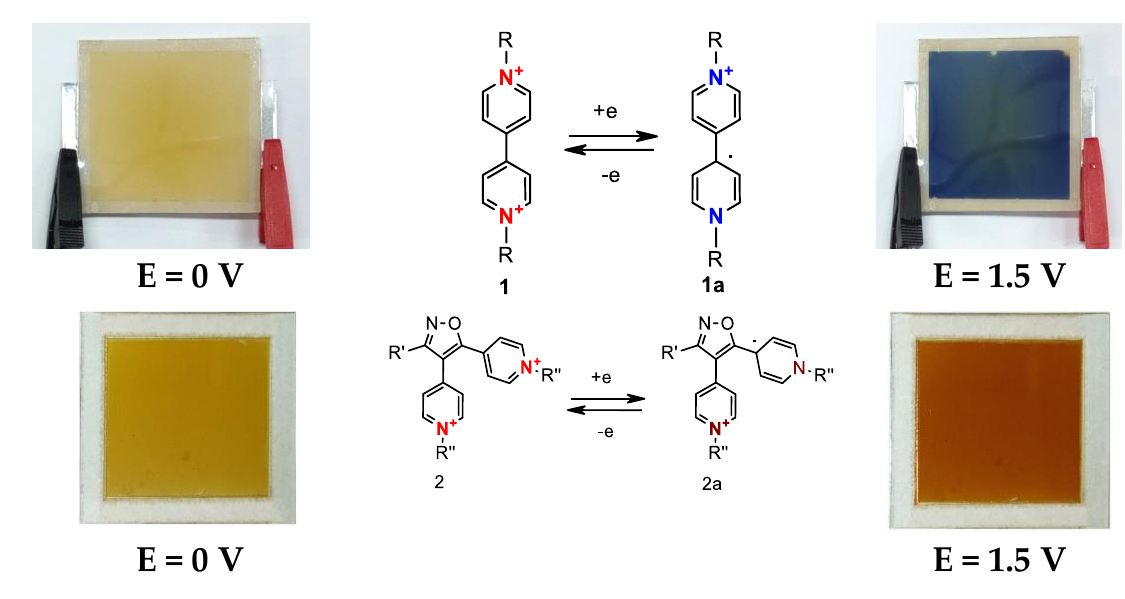
Figure 8. Electrochromic transition cycle.